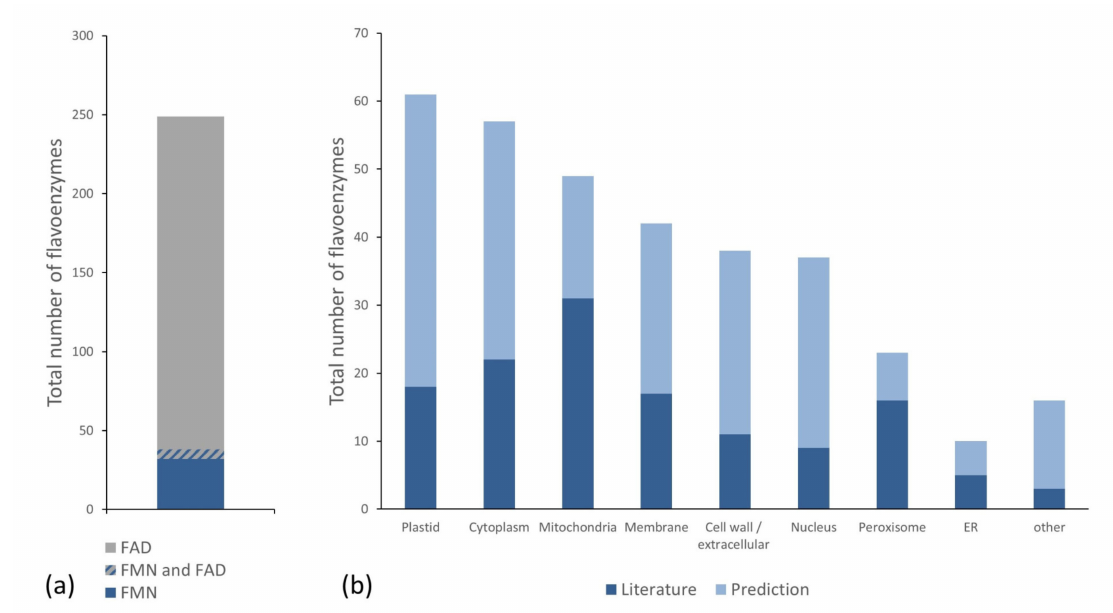
Figure 1. General statistics of the flavoproteome. ( a ) Shows the distribution of the flavocoenzymes flavin mononucleotide (FMN) and flavin adenine dinucleotide (FAD) among the flavoenzymes. ( b ) Shows the number of flavoenzymes, targeted to the indicated localization. Localizations described in the literature are represented in dark blue. For other flavoenzymes, we used gene ontology (GO) and UniProt annotations to predict the localization (pale